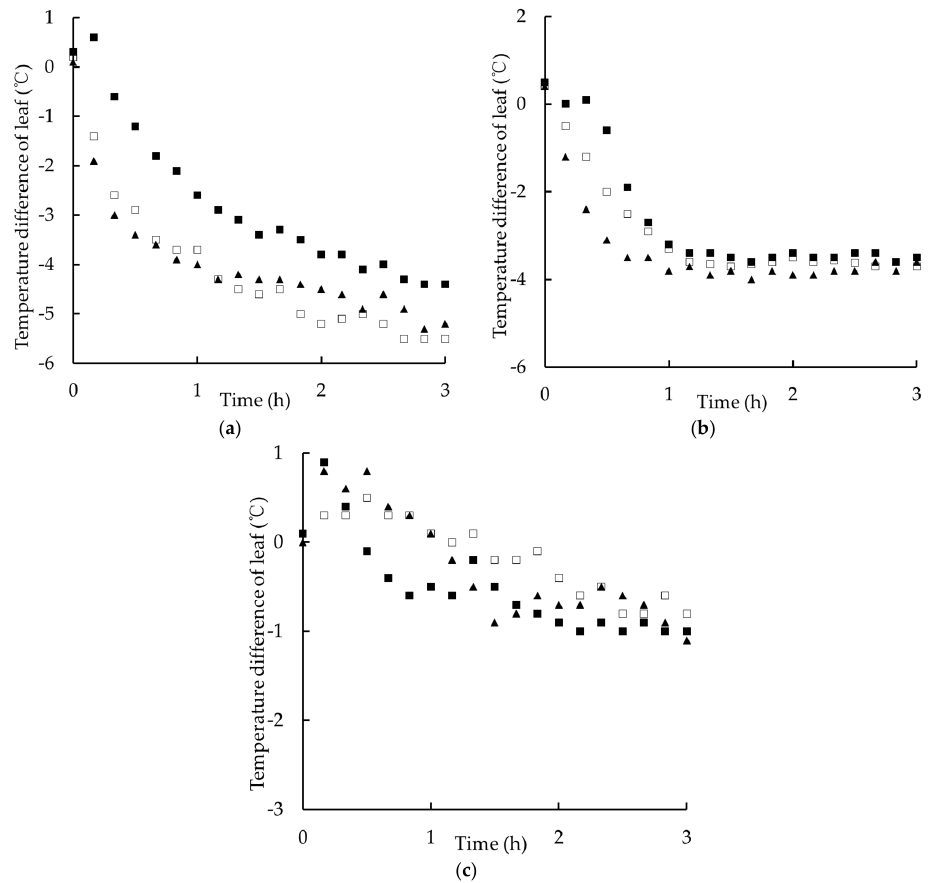
Figure 9. T radiation was set to − 40 °C ( a ); − 20 °C ( b ) and 0 °C ( c ), while the T basic was set to − 5 °C ( ■ ), 0 °C ( ▲ ), 5 °C ( □ ), respectively.